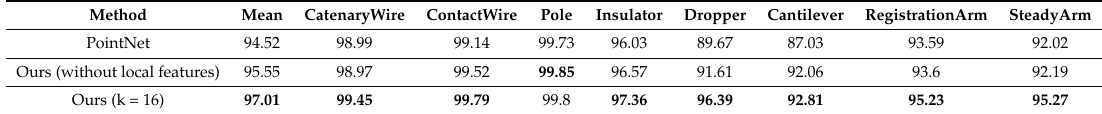
Table 1. Segmentation accuracy (%)